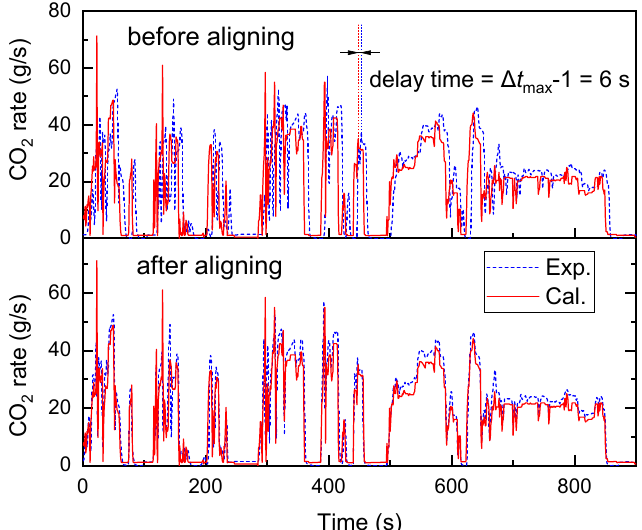
Figure 10. Experimental and calculated CO 2 rate, before and after aligning (vehicle one).